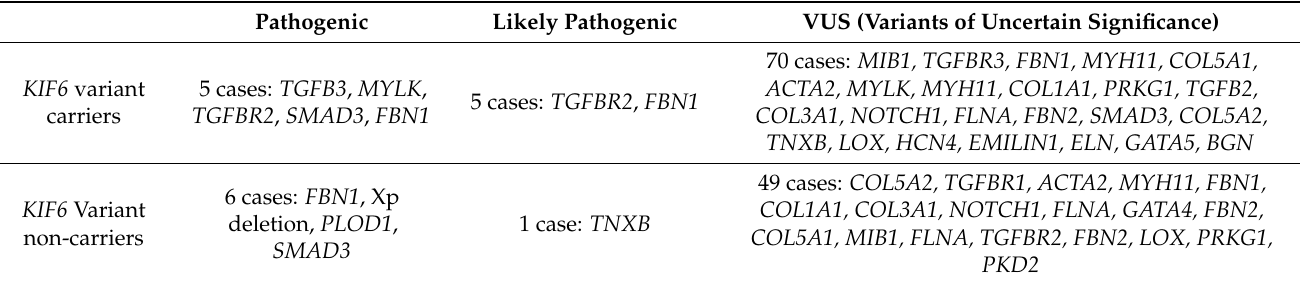
Table 6. Genetic variants found on whole exome sequencing of patients in this study. These are classi- fied here according to the standard American College of Medical Genetics and Genomics